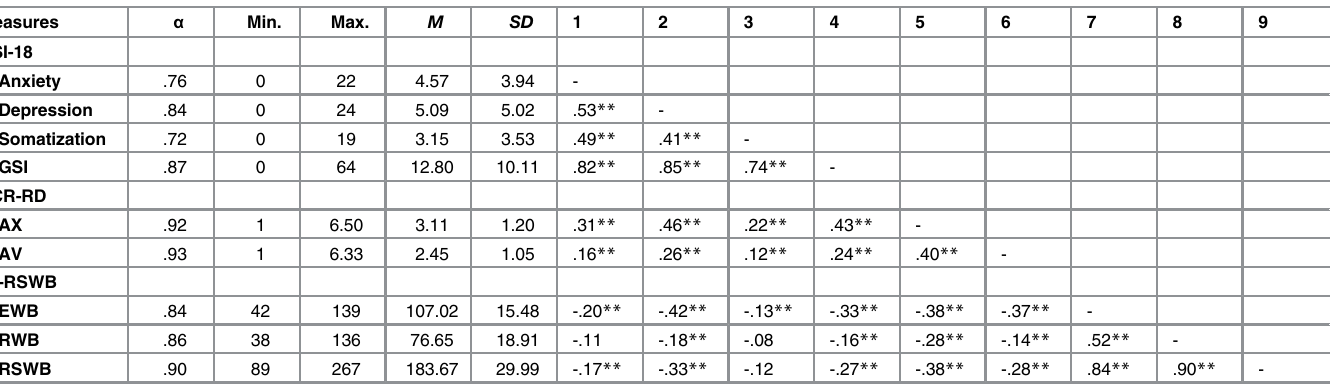
Table 1. Descriptive characteristics and intercorrelations of study